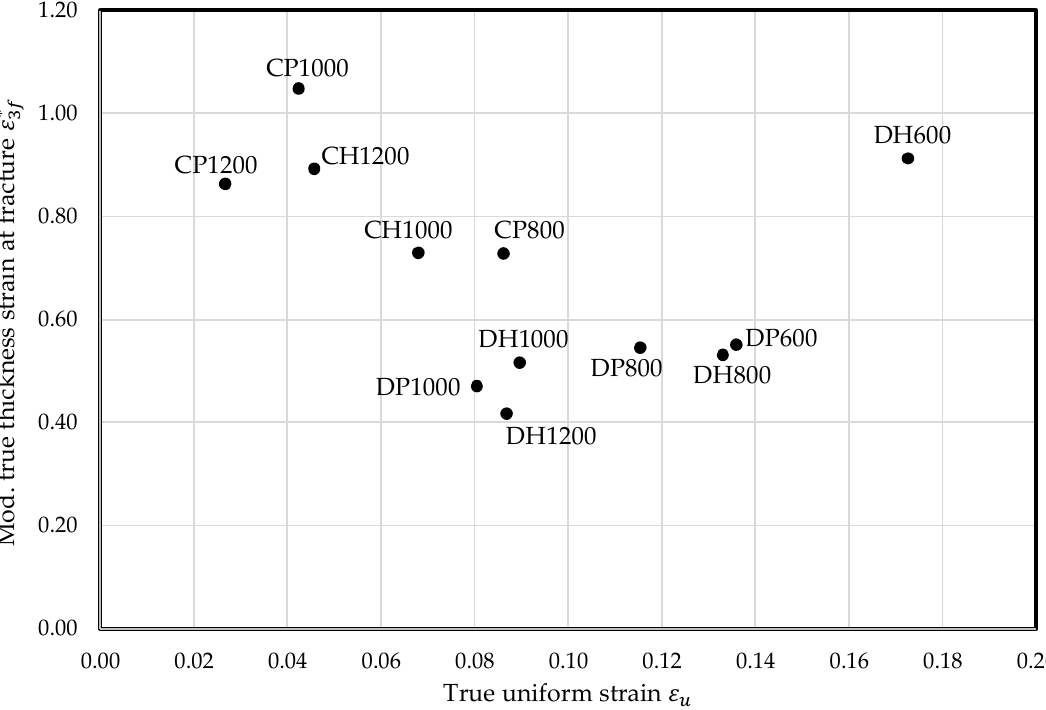
Figure A8. Modified global and local formability diagram: modified true thickness strain at fracture—true uniform strain.